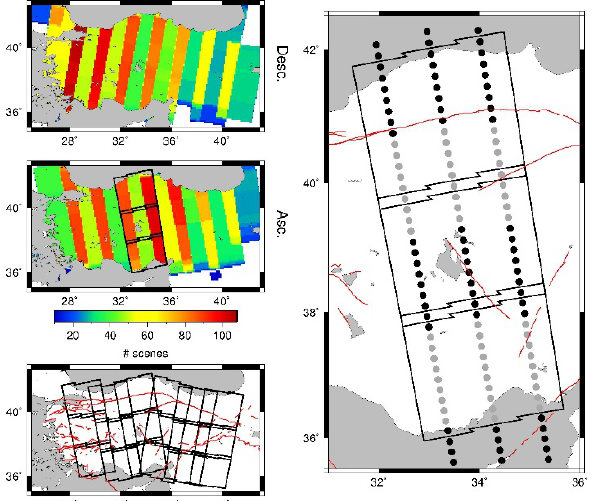
Figure 4. The North Anatolian Fault (Western Turkey) has been selected as a tectonic scenario.